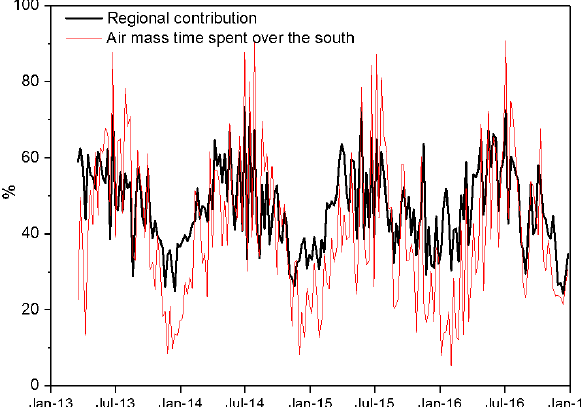
Figure 9. Four-year cycle of contributions from outside Beijing (black line) and the proportion of time (of 5d) spent over southern quadrants (red